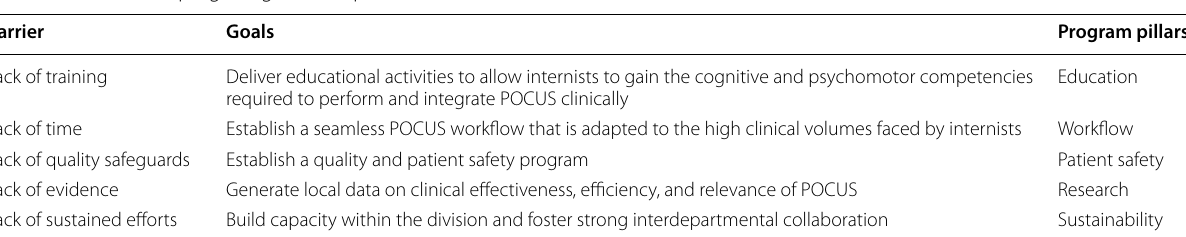
Table 2 GIM POCUS program goals and pillars Barrier Goals Lack of